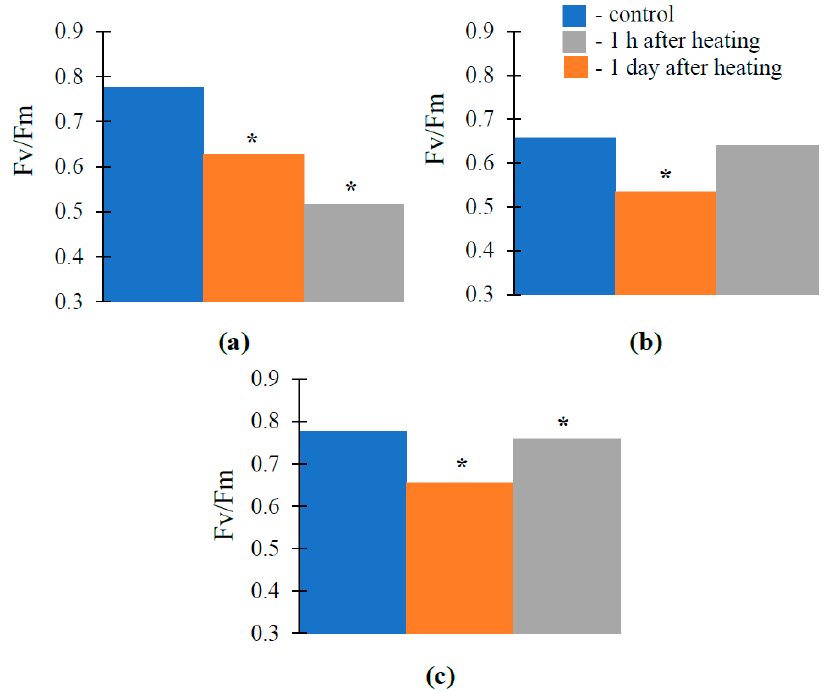
Figure 6. Maximal quantum yield of photosystem II (Fv/Fm) in control and in 1 h and one day after heating of whole plant for ( a ) pea, ( b ) wheat, and ( c ) pumpkin. Seedlings were heated in a TV-20-PZ-K thermostat for 30 min at 46.5 °C for pea and pumpkin and 44 °C for wheat. Medians are shown in the figure. * Value significantly differed from control ( p < 0.05, Mann–Whitney U test).